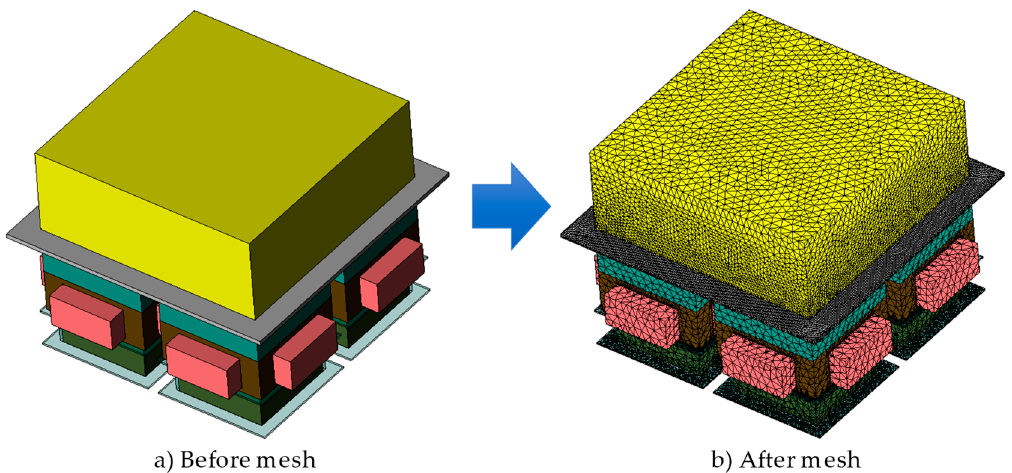
Figure 11. Mesh shape in the conventional model ( a ) before mesh; ( b ) after mesh.